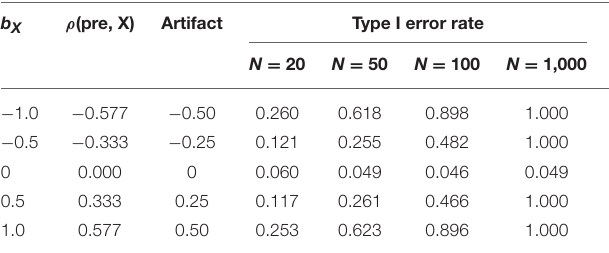
TABLE 2 | Type I error rates for assessing the relationship between a continuous predictor and posttest, controlling for pretest. b X ρ (pre, X) Artifact Type I error